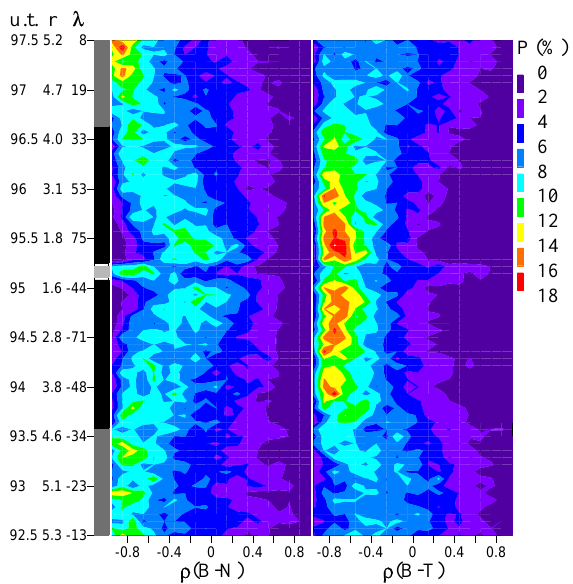
Fig. 3. Solar rotation histograms of ρ(B − N) and ρ(B − T ) in the same format of Fig. 2, apart from a change in the colour scale for the occurrence frequency P .